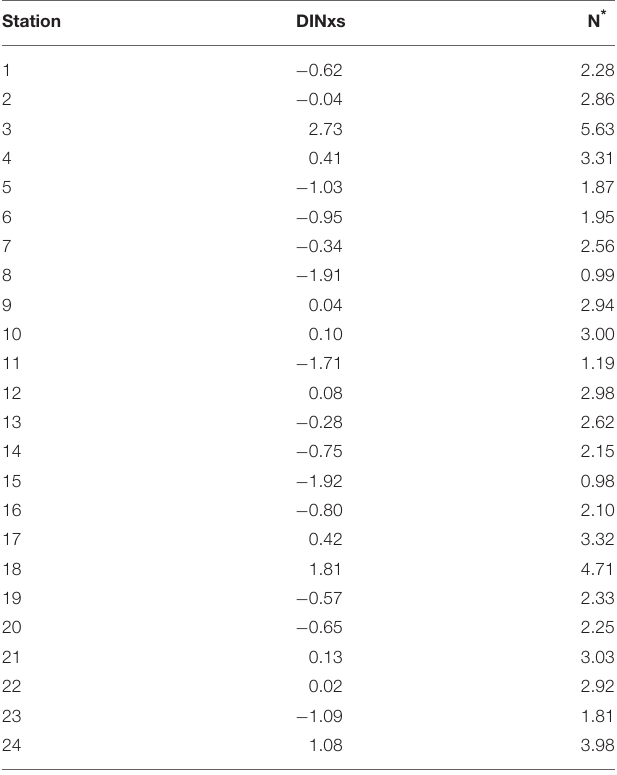
, DIC, and TA Concentrations Relations between SiO − 2 We used the conservative theoretical mixing lines and the mixing , TA and DIC concentrations line of observed data for the SiO − 2